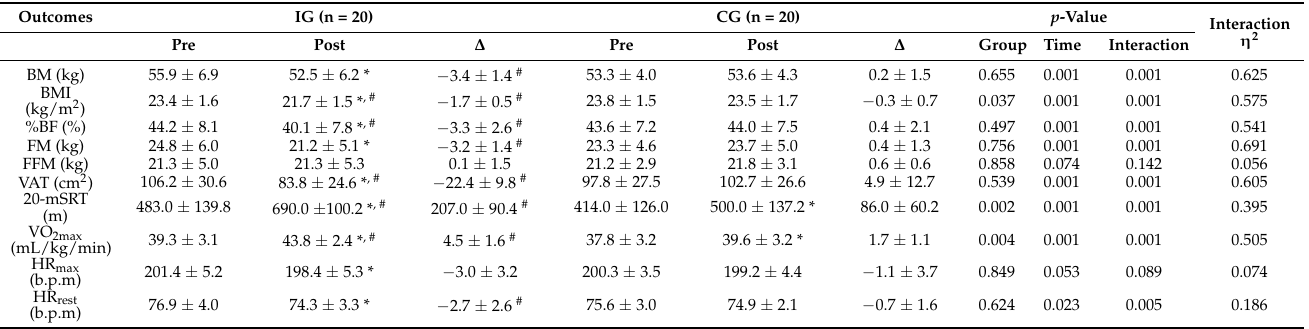
Table 2. Changes in the outcomes from pre- and post-intervention for the intervention group (IG) and control group